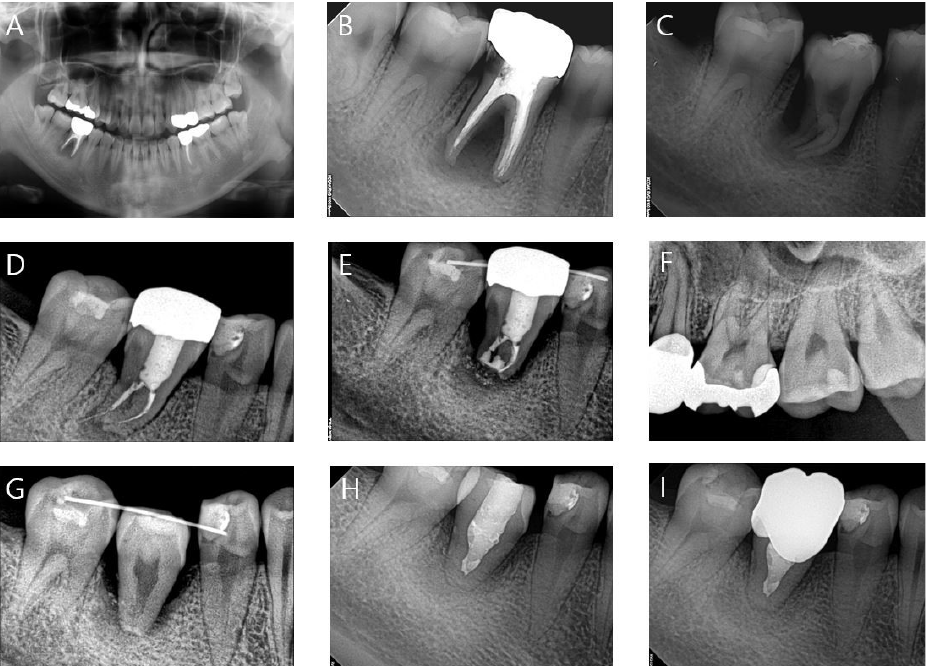
Figure 1. ( A , B ) Panoramic and periapical view at first visit. Periapical view immediately ( C ) and 7 years ( D ) after first autogenous tooth transplantation from #48 to #46. ( E ) 2 months after root resection ( F ). Periapical view of donor site (#28). Periapical view after 1 week ( G ), 3 months ( H ) and 18 months ( I ) after second autogenous tooth transplantation from #28 to #46.